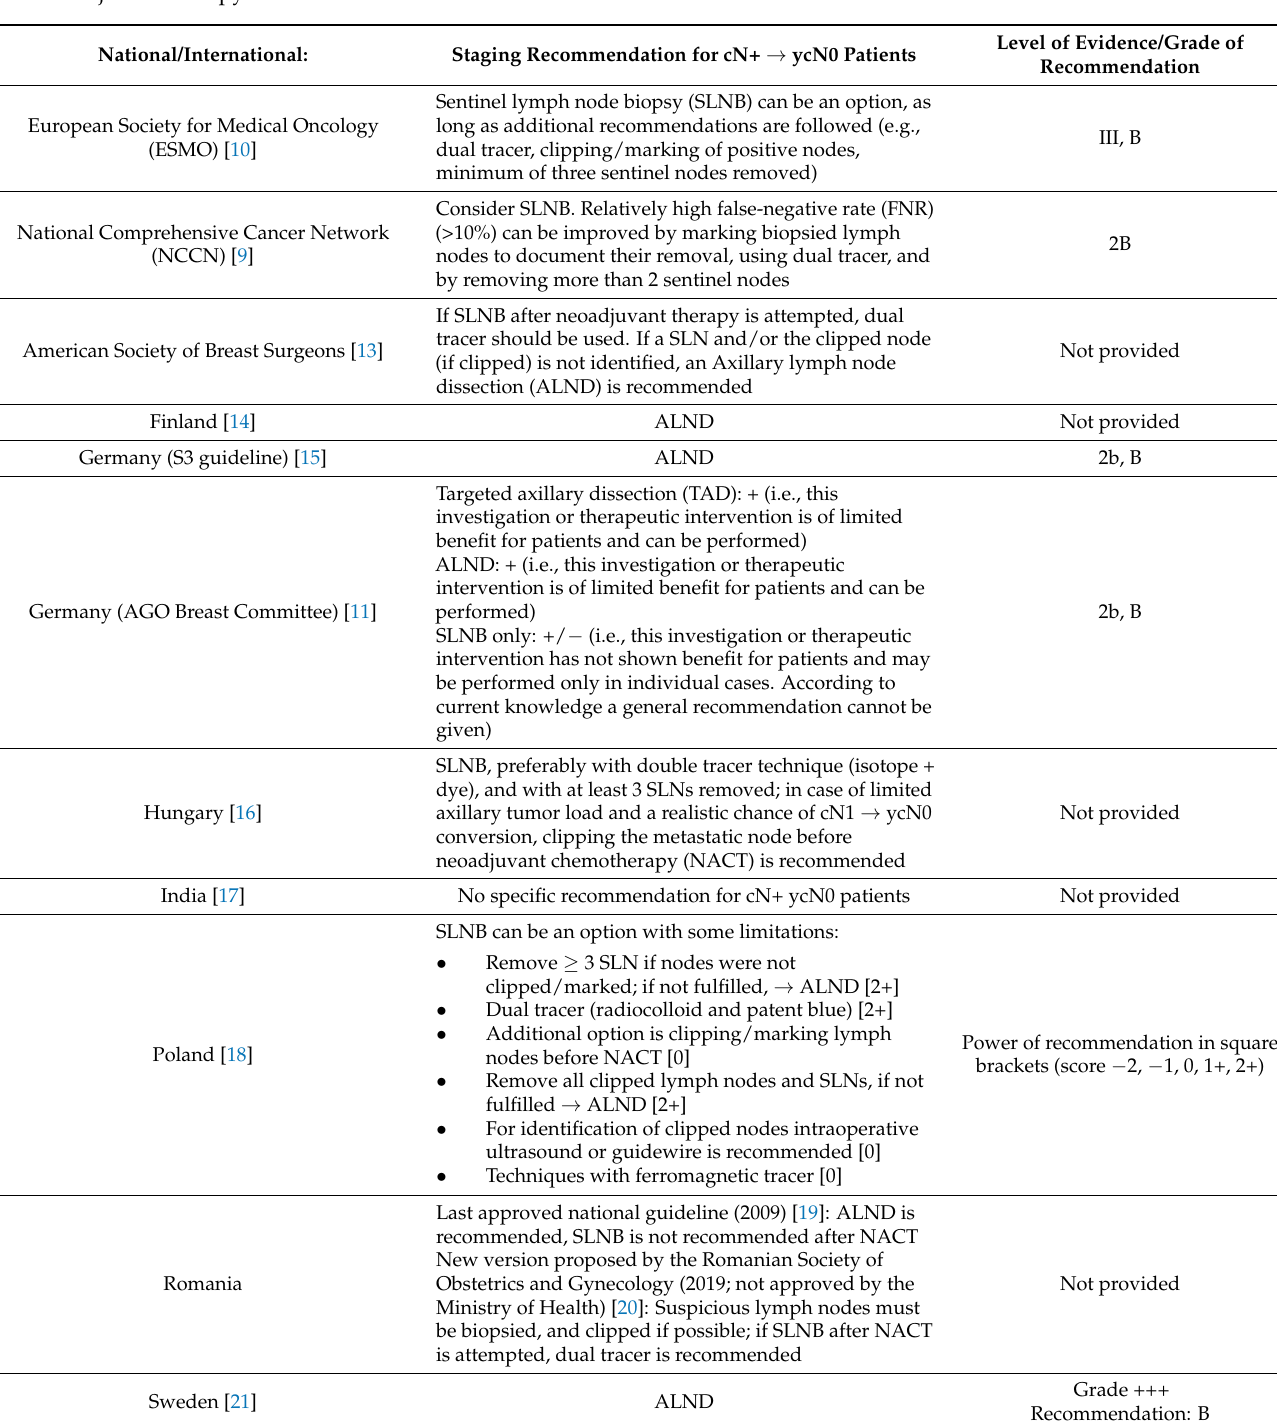
Table 2. National and international guidelines on axillary surgical staging in initially node-positive patients receiving neoadjuvant